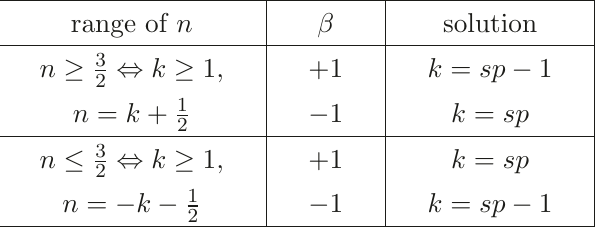
Table 2 . Quantization conditions on the fermion zero modes imposed by orbifold invariance. modes ξ ( k )+ m and ξ ( k )+ m along AdS 2 , enumerated in appendix A, in the following